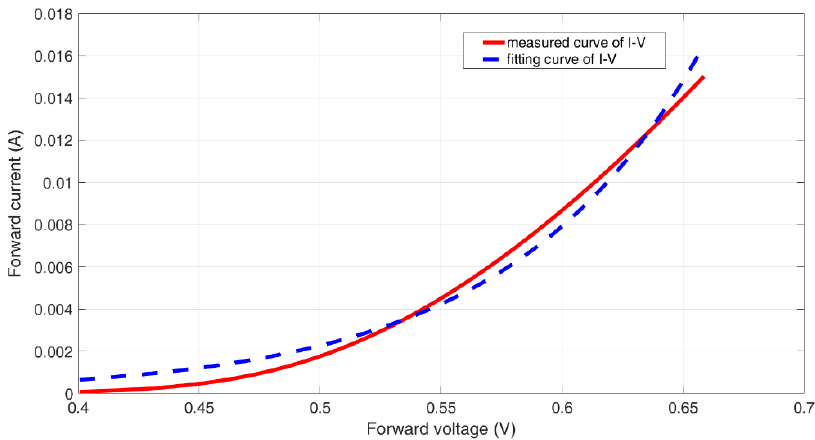
Figure 8. The comparison between the fitted and measured curve of